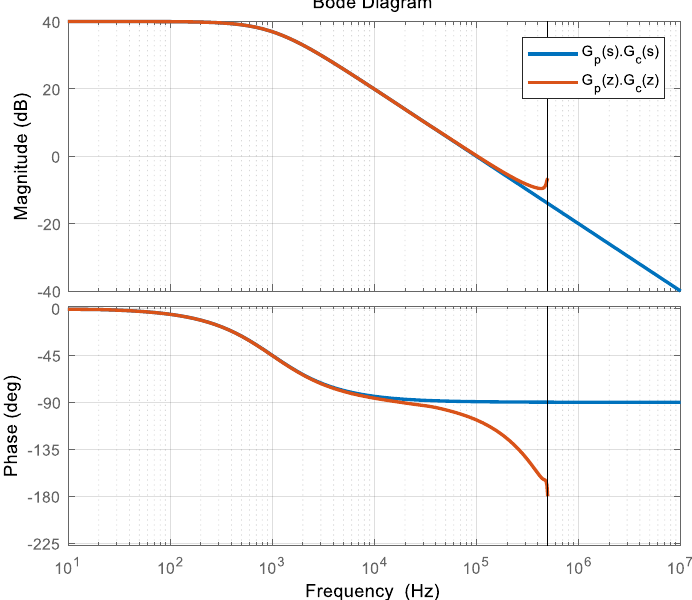
Figure 7. Bode plot of the open-loop compensated buck converter system.